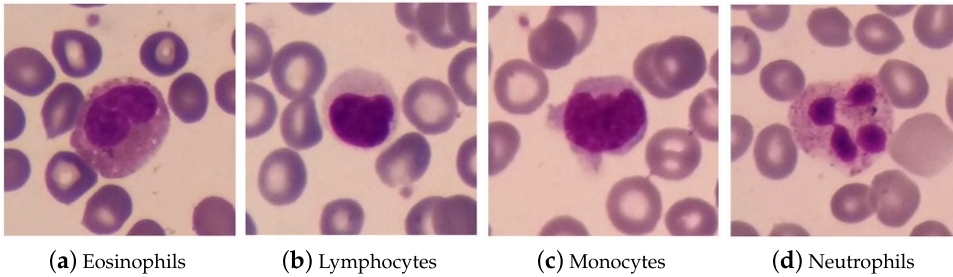
Figure 1. Example of different white blood cell